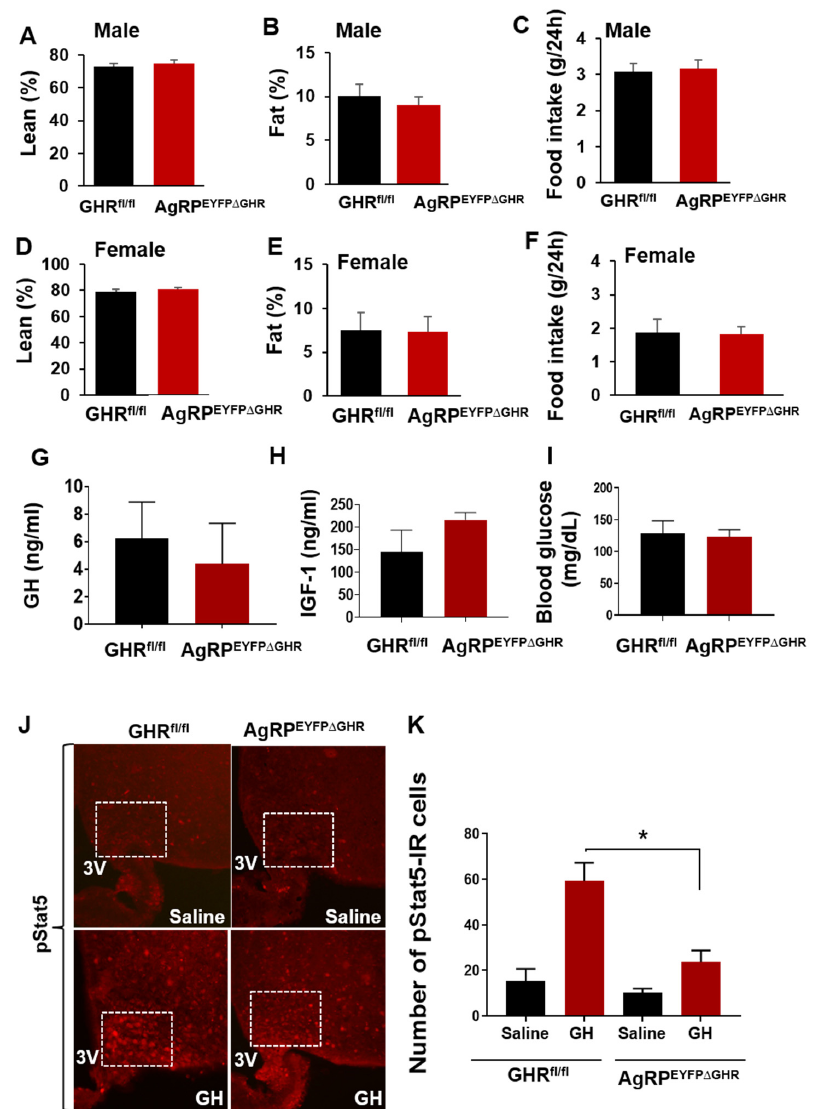
Figure 2. Weight and hormonal levels of agouti-related protein (AgRP) EYFP ∆ GHR mice. ( A ) Lean mass, ( B ) fat mass, and ( C ) food intake of control and AgRP EYFP ∆ GHR male mice. ( D ) Lean mass, ( E ) fat mass, and ( F ) food intake of control and AgRP EYFP ∆ GHR female mice. ( G ) Serum growth hormone (GH), ( H ) serum IGF-1, and ( I ) fasted blood glucose levels of control and AgRP EYFP ∆ GHR male mice, n = 7–8 per group. ( J ) Representative image of STAT5-IR (red) in the ARC of control and AgRP EYFP ∆ GHR male mice induced by saline or GH (ip). ( K ) Quantification of pSTAT5 + cells in the ARC of control and AgRP EYFP ∆ GHR mice. Mean ± SEM. *, p < 0.05. n = 4–5. The 3V, third ventricle.